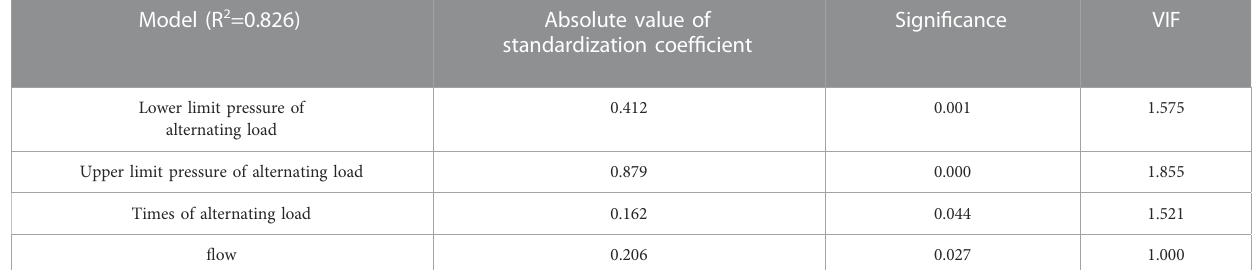
TABLE 6 Analysis